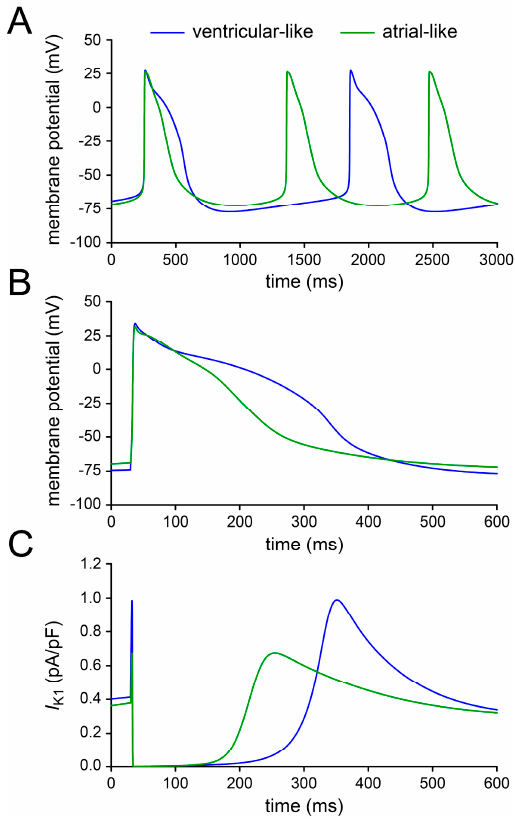
Figure 7. Electrical activity of the ventricular-like and atrial-like hiPSC-CM model cells of Paci et al. [30,31]. ( A ) Spontaneous action potentials. ( B ) Action potentials and ( C ) associated intrinsic inward rectifier potassium current ( I K1 ) during 1 Hz overdrive stimulation on an expanded time scale.